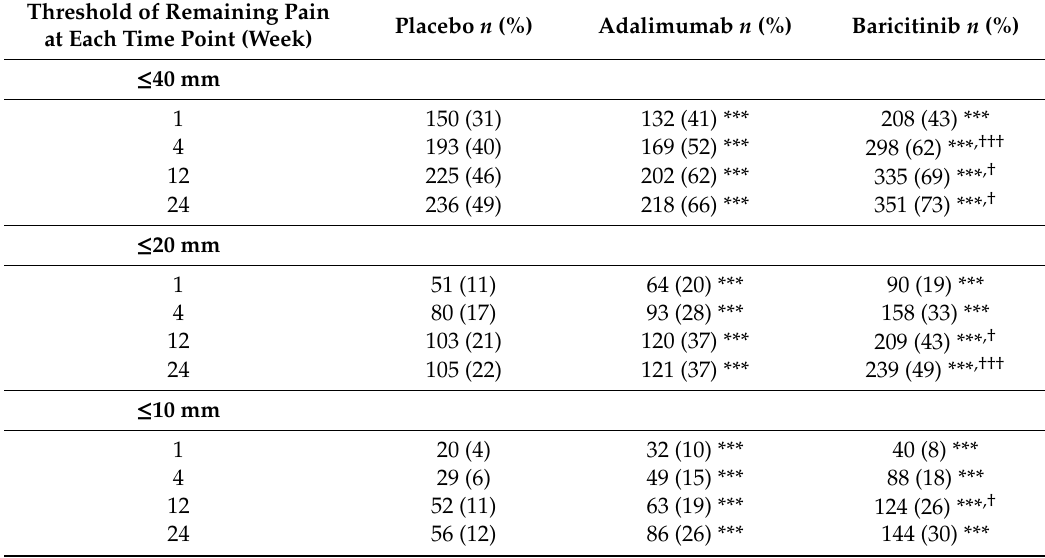
Table 1. Percentage of patients who met the thresholds of remaining pain (VAS) over time by treatment